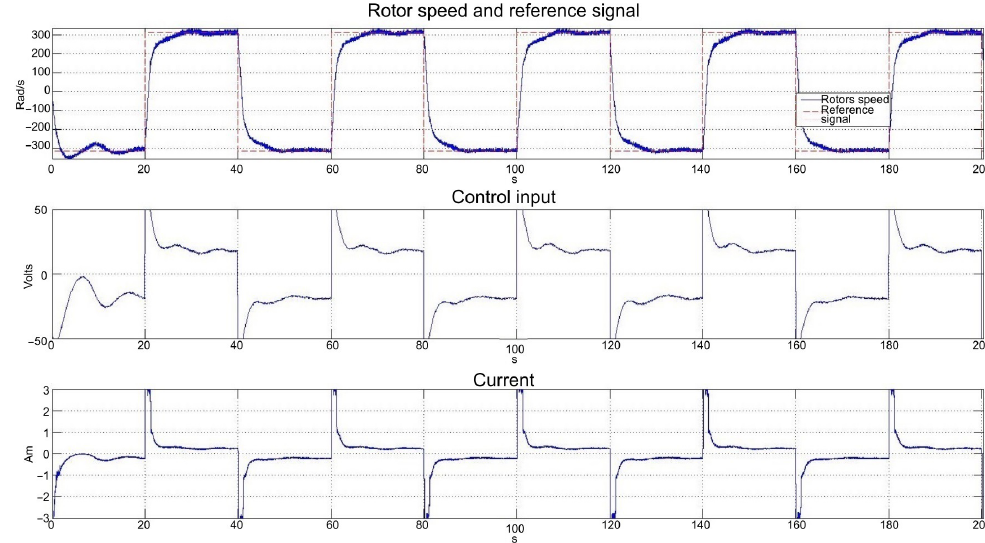
Figure 21. Responses to a train of square pulses reference